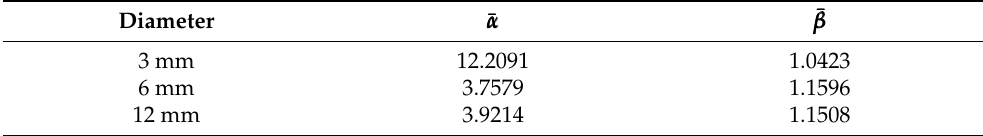
Table 4. Assessment of shape and scale parameters from the experimental